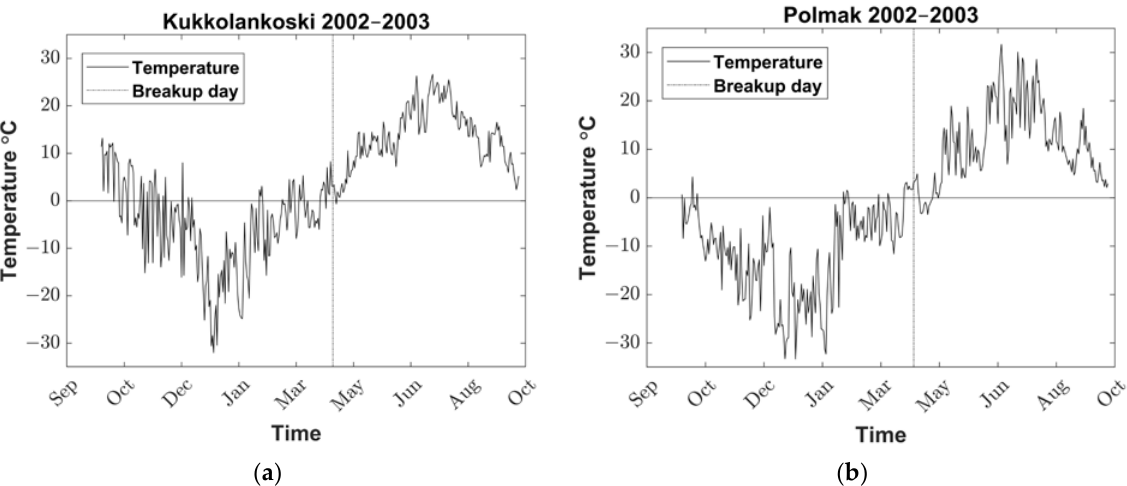
Figure 10. ( a ) Intersection of BUD in Kukkolankoski station, and the start of the temperature-posi-